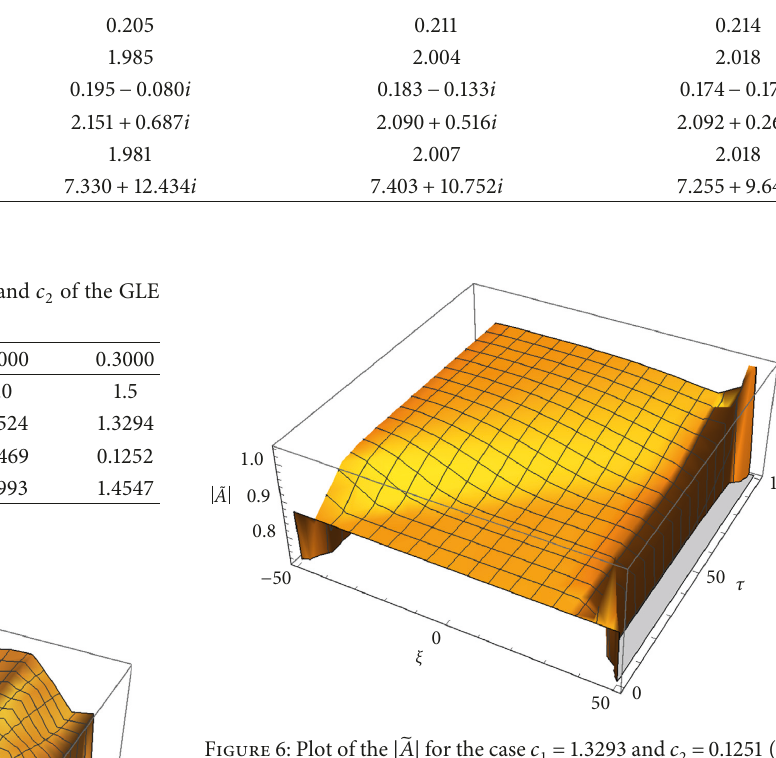
� 1.3293 and c � 0.1251 (the 􏽰 ����� 1 2 e iq ξ where q � 0.5). 1 − q 2